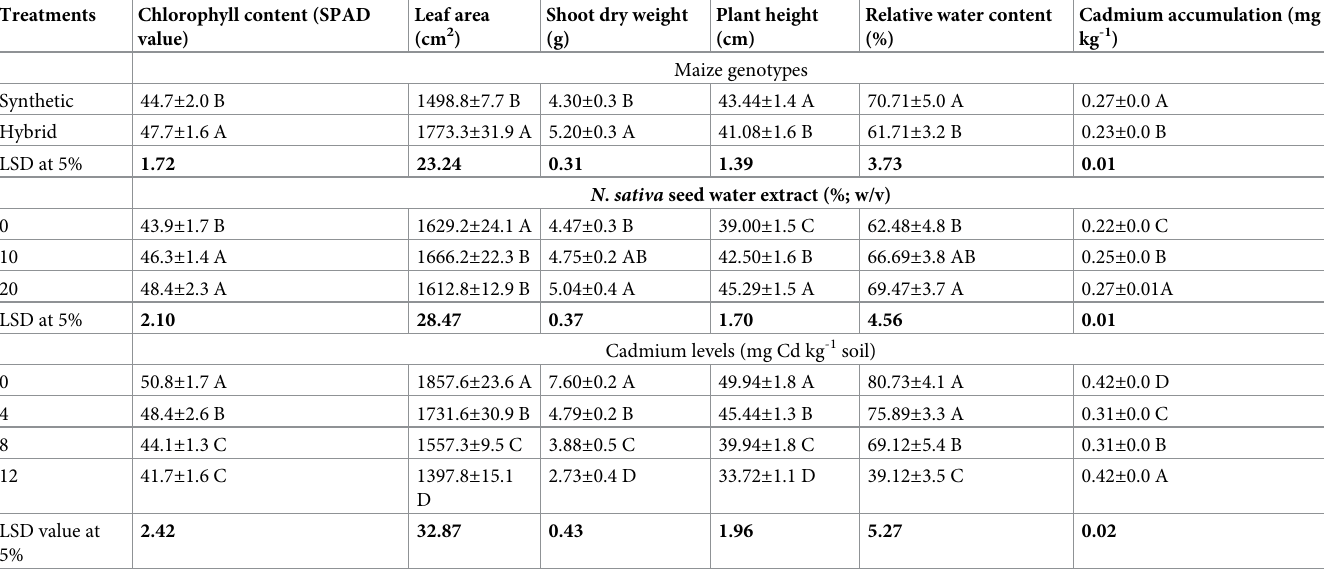
Means sharing the same case letter for a parameter within a column did not differ significantly from each other at p >